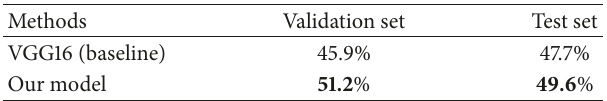
Non-Maximum Suppression (NMS) with a threshold of 0.3 Table 1: The Average Precision (AP) on the Oxford Validation and Testing Set. All hand instances were used for